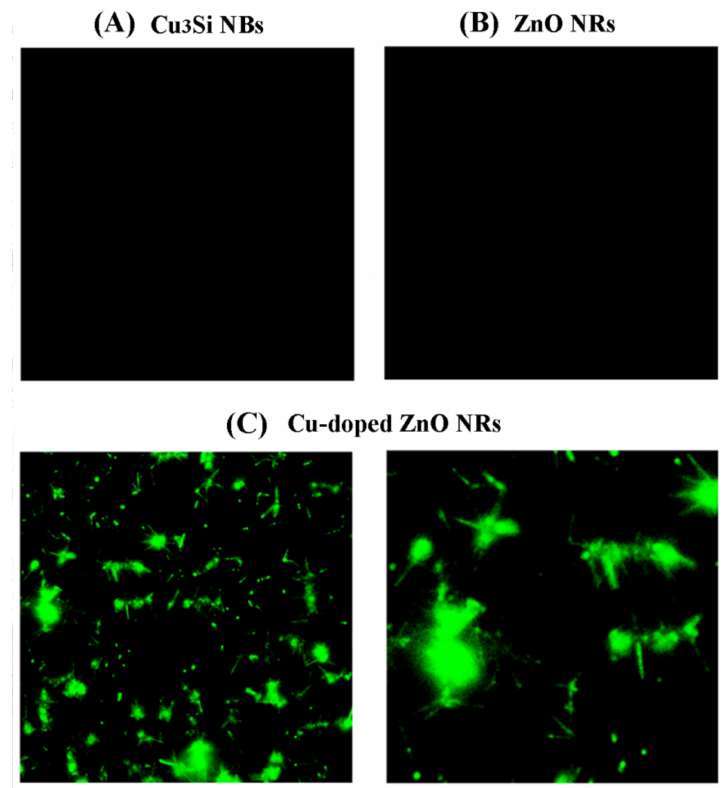
Figure 2. Fluorescence panels of the Cu 3 Si NB, Cu-doped ZnO NRs on Cu 3 Si NB, and neat ZnO NR containing ( A ) Cu 3 Si NBs and ( B ) undoped ZnO NRs; ( C ) In contrast, strong fluorescence from